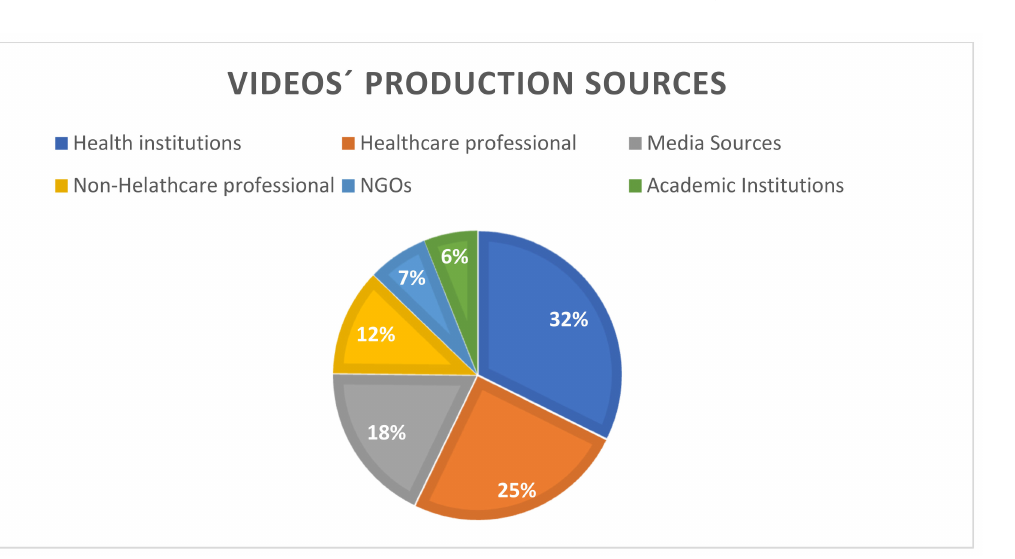
Figure 2. Video production